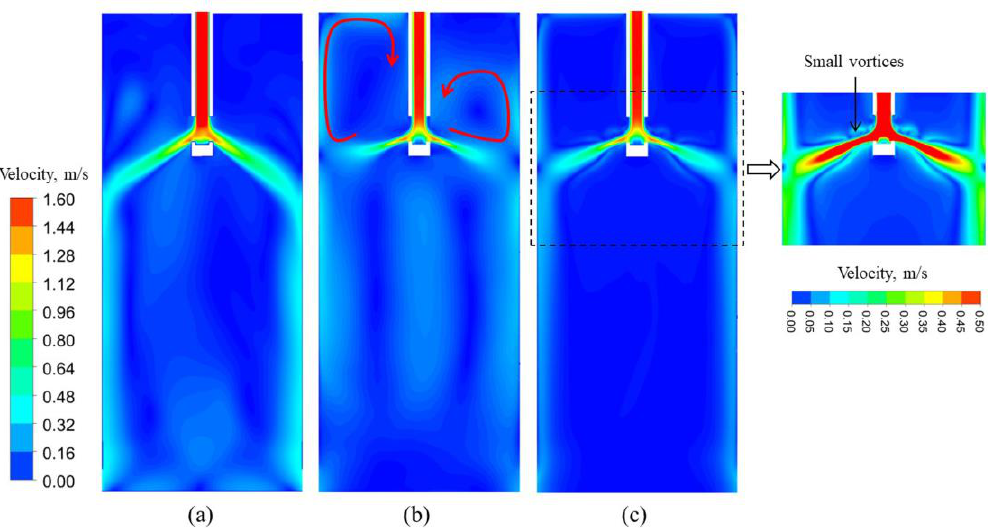
Figure 9. Contours of time-averaged velocity: ( a ) No EMBr; ( b ) EMBr with electrically-insulated walls; ( c ) EMBr with electrically-conducting walls.